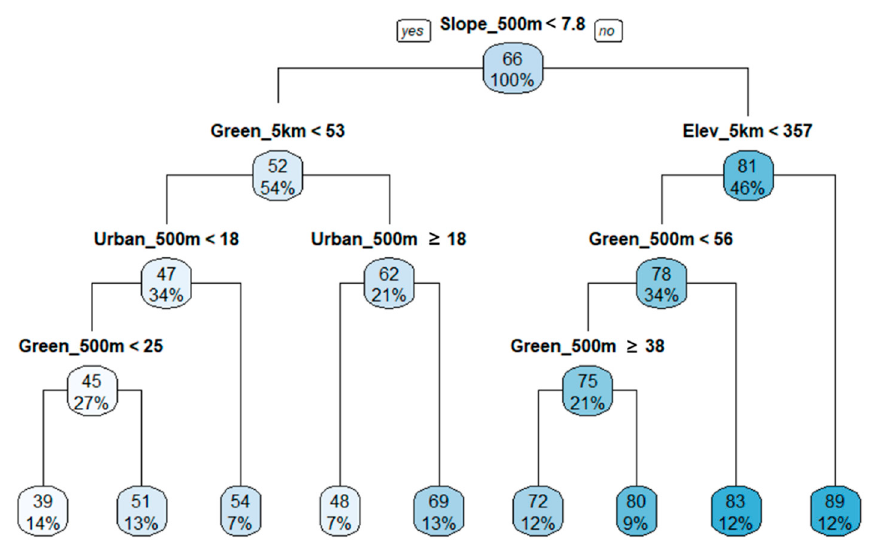
Figure 6. Regression tree for BMI with stream topographical variables and proportions of green and urban areas in buffer areas (R 2 = 0.78). The numbers located on top in color boxes are mean values of BMI.